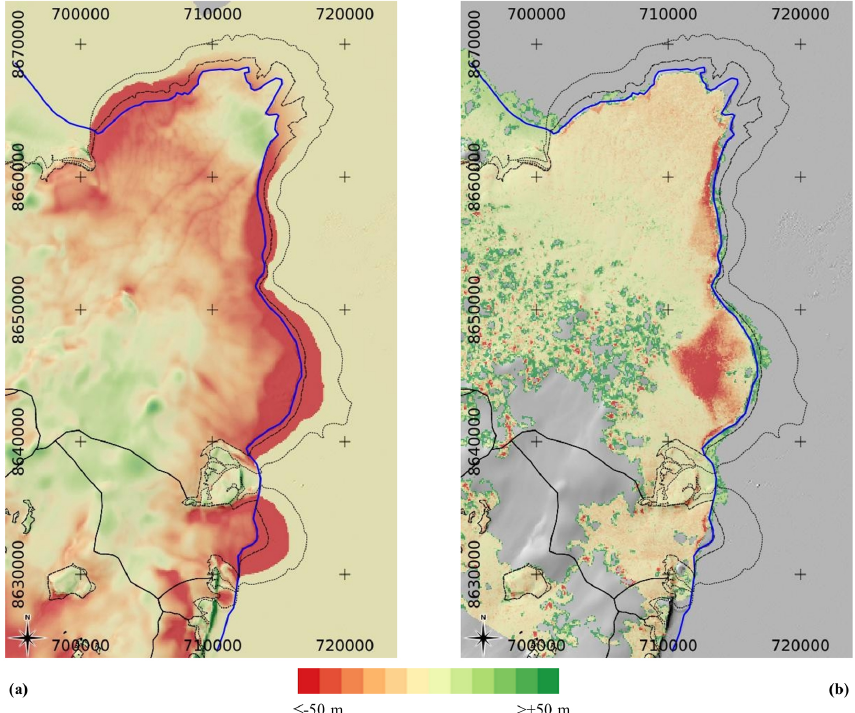
Figure 3. Glacier elevation change between (a) IDEM and NPI DEM (time lapse 2010/2012–1970) and (b) ASTER DEM and IDEM (time laps 2014–2010/2012). Image background is a shaded relief of IDEM. The coastal outline from the Landsat imagery of 2011 (blue line) is shown along with glaciers inventories of 1971 (dotted line) and 2006–2007 (dashed